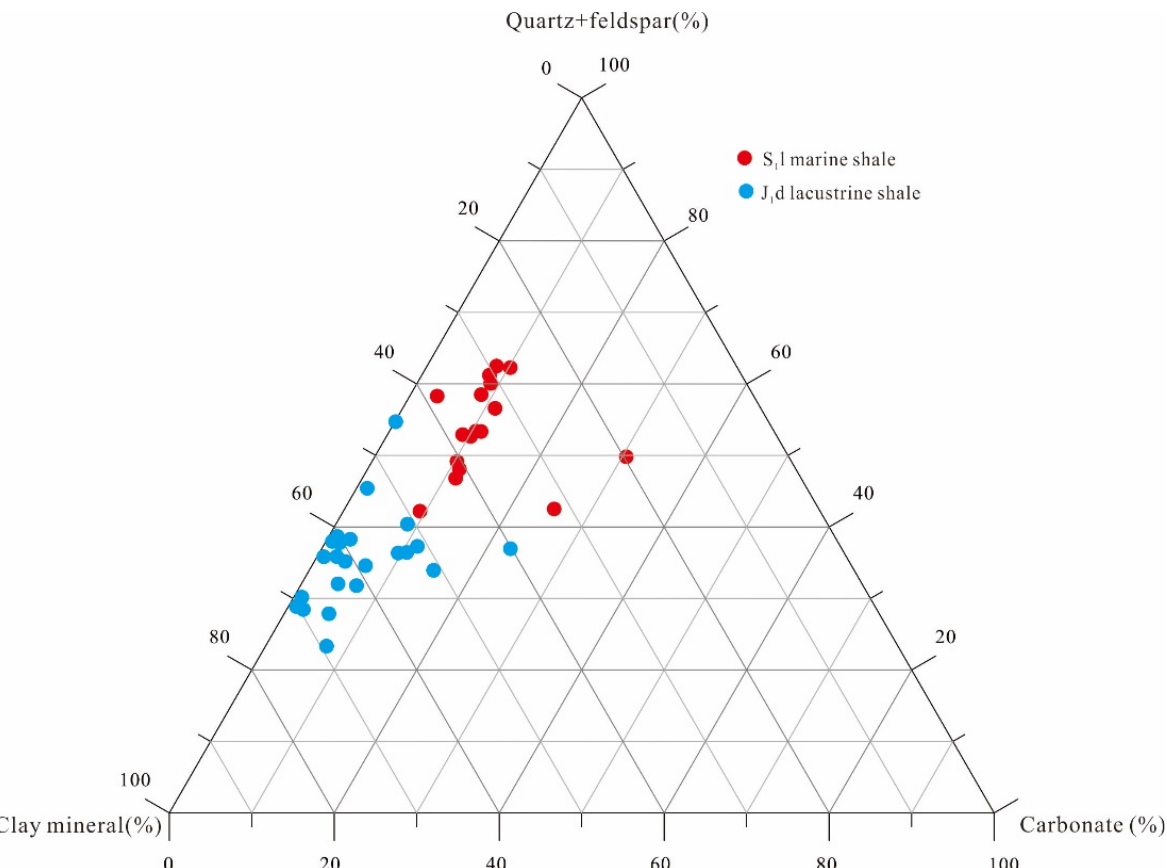
Figure 2. Histogram showing the measured TOC of the Silurian Longmaxi marine-shale samples and the Lower Jurassic Dongyuemiao lacustrine-shale samples.